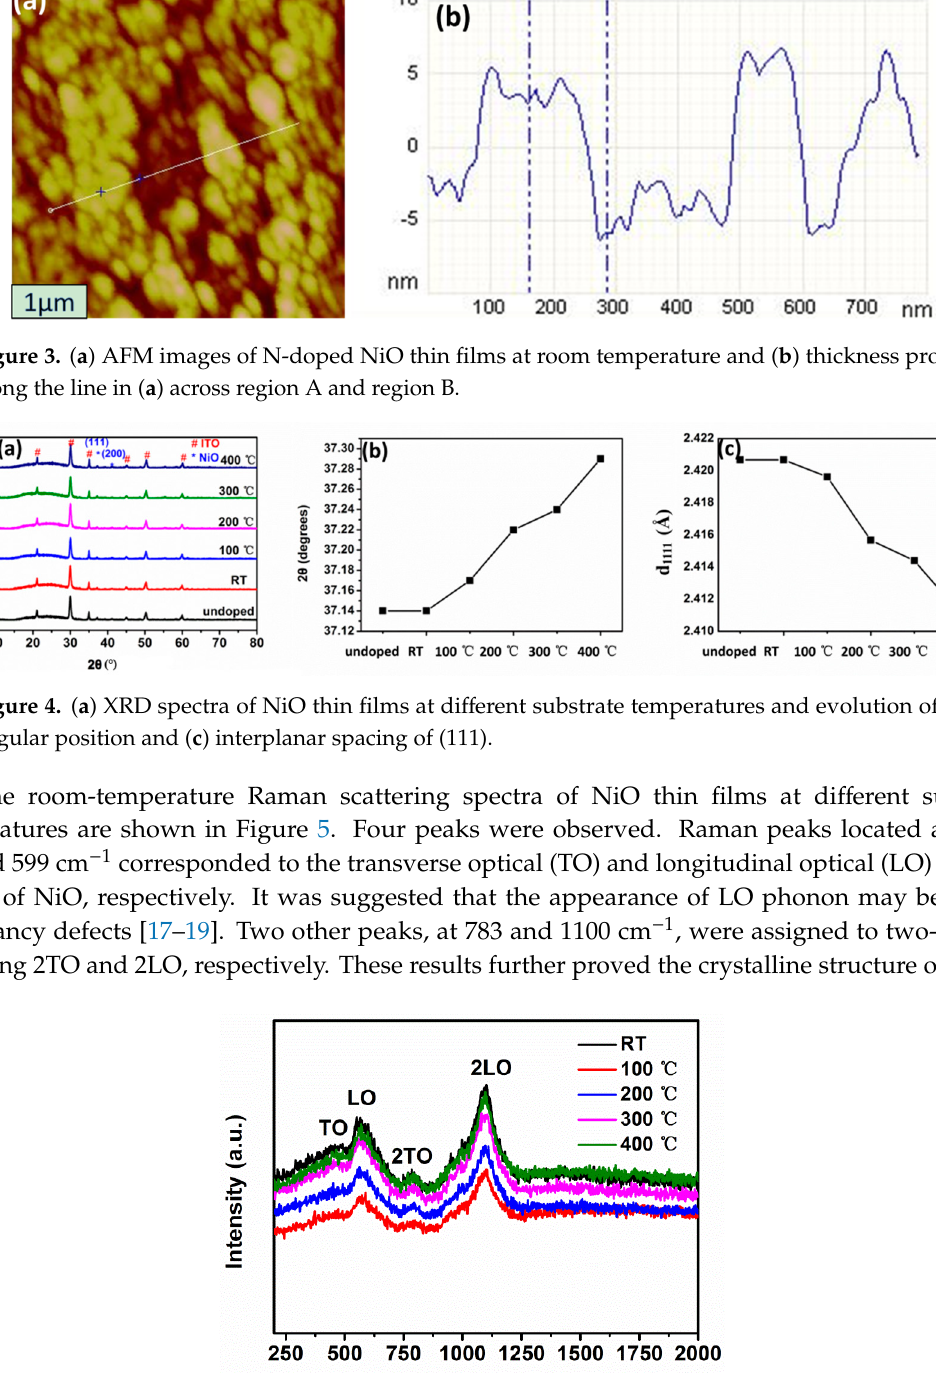
Figure 4. ( a ) XRD spectra of NiO thin films at different substrate temperatures and evolution of ( b ) angular position and ( c ) interplanar spacing of (111).